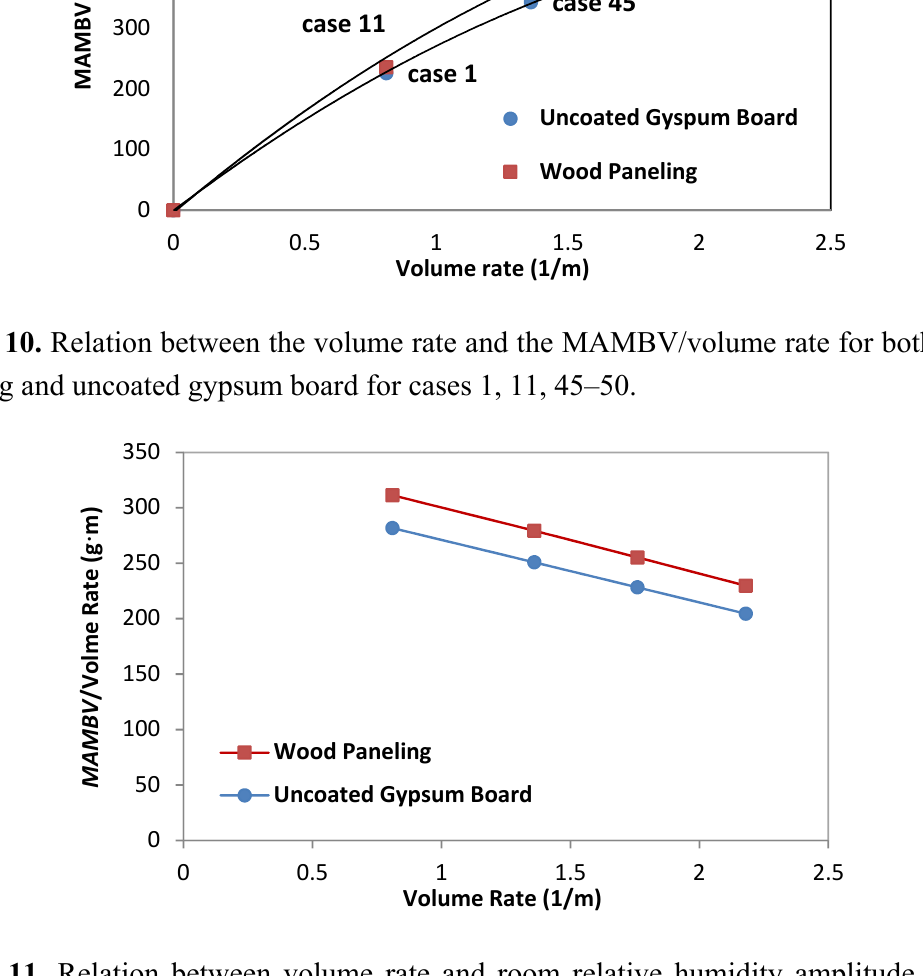
Figure 11. Relation between volume rate and room relative humidity amplitude for the uncoated gypsum board under supply air humidity at 4.7 g/kg (cases 1, 45, 47, and